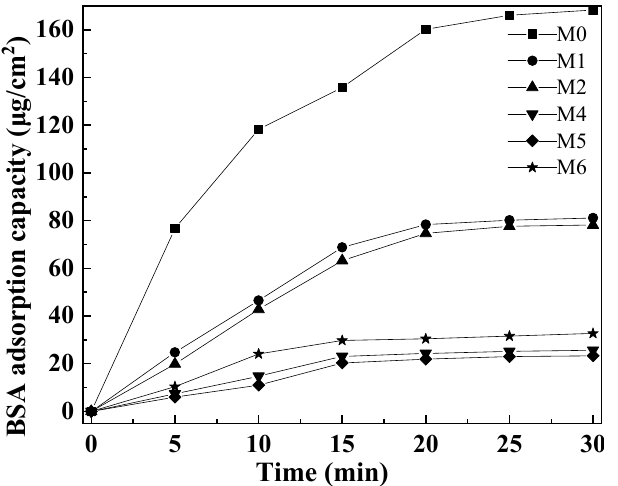
Figure 11. BSA dynamic adsorption of the composited membranes with various amounts of mCNTs grafting single and diblock chains and membranes with oriented or unoriented mCNTs.